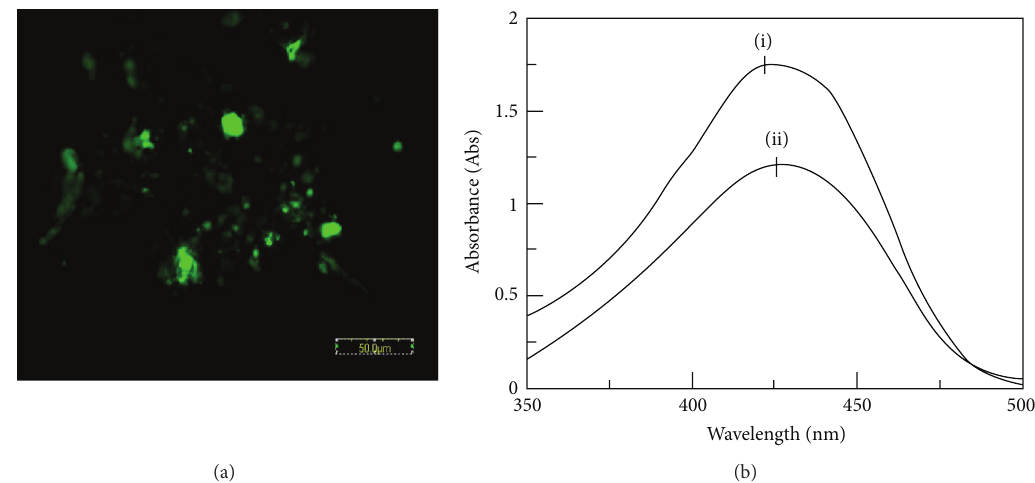
Figure 3: (a) Fluorescent image of curcumin loaded starch nanoparticles and (b) UV spectra of (i) curcumin solution and (ii) curcumin loaded starch nanoparticles.